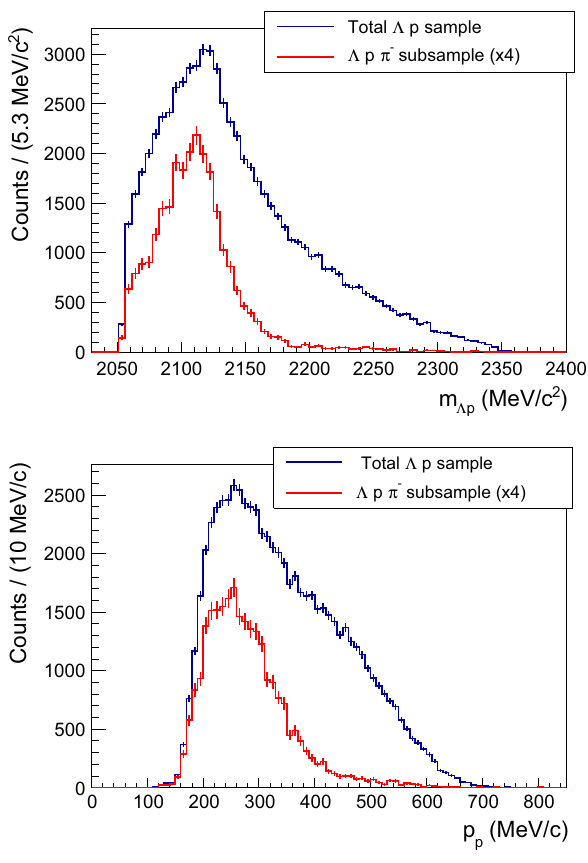
Fig. 1 (cid:2) p invariant mass (top) and proton momentum (bottom) distri- butions are shown for the whole (cid:2) p data sample (blue) together with the (cid:2) p π − subsample events (red). The red distribution is multiplied by